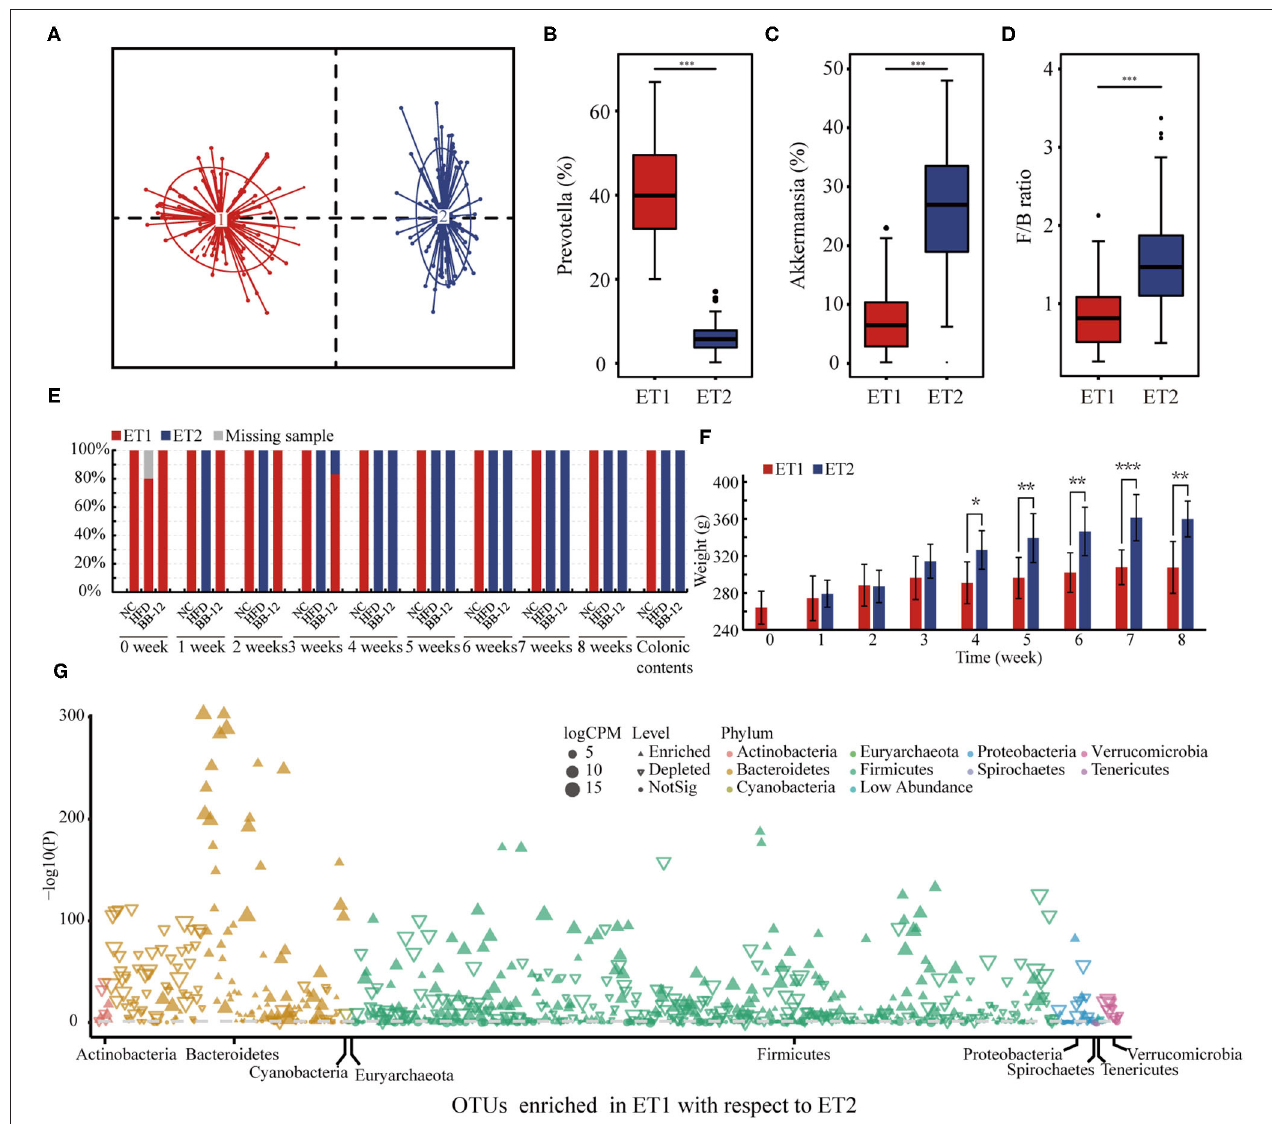
FIGURE 6 | Enterotype (ET) analysis based on the genus-level bacterial composition of the gut microbiota. (A) 159 samples were divided into two different ETs; (B,C) represent the relative abundance of Prevotella and Akkermansia in each ETs, respectively; (D) represents the Firmicutes/Bacteroidetes ratio into two different ETs; (E) distribution of ETs by each group; (F) represents the body weight in different ETs; (G) Manhattan plot showing OTUs being enriched in ET1 or ET2; each dot or triangle represents a single OTU. OTUs enriched in ET1 or ET2 are represented by filled or empty triangles, respectively (FDR adjusted p < 0.05). OTUs are arranged in taxonomic phylum. OTUs, operational taxanomic units; FDR, false discovery rate; CPM, counts per million; ET1, enterotype 1; ET2, enterotype 2. * p < 0.05; ** p < 0.01; *** p <